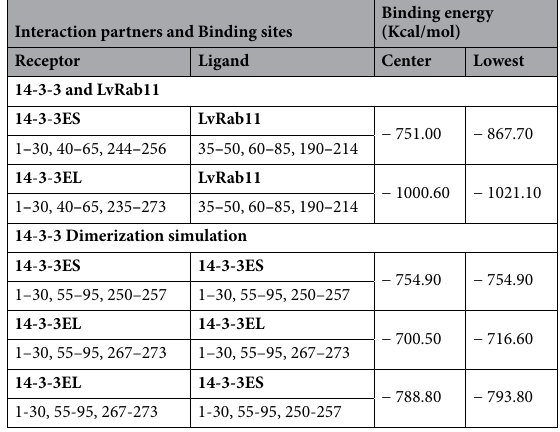
Table 1. Docking simulation results for 14-3-3ε and